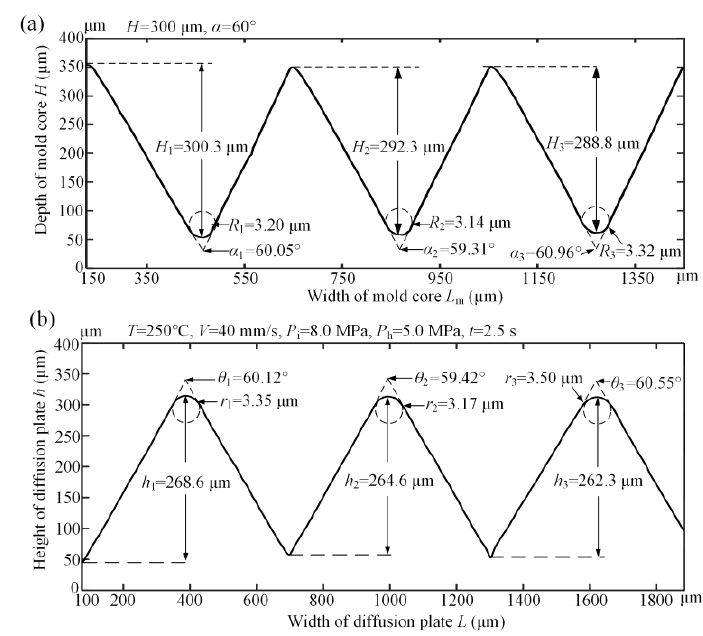
Figure 12. The section profile curves of the micro-structured mold core and diffusion plate sample: ( a ) mold core; ( b ) diffusion plate sample.